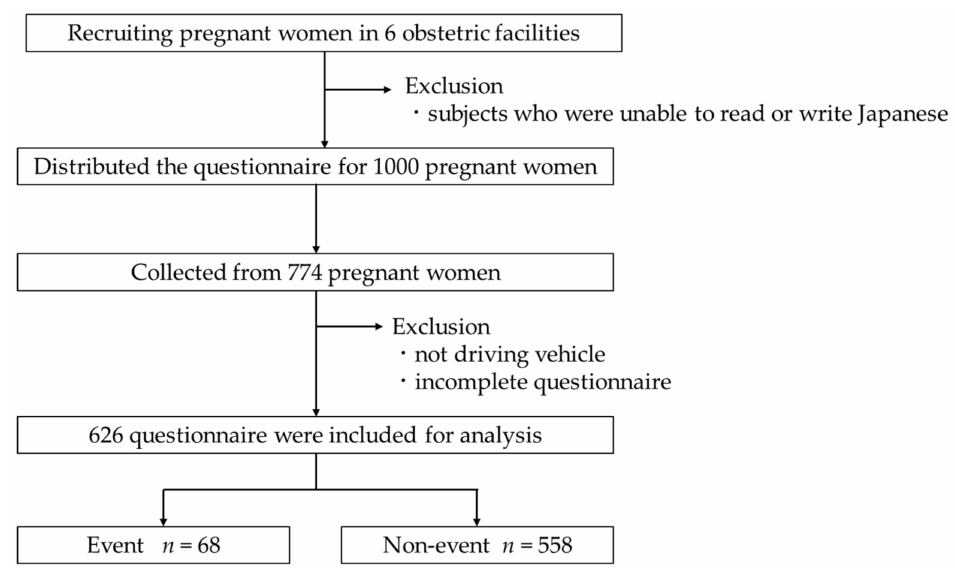
Figure 1. Overview of study